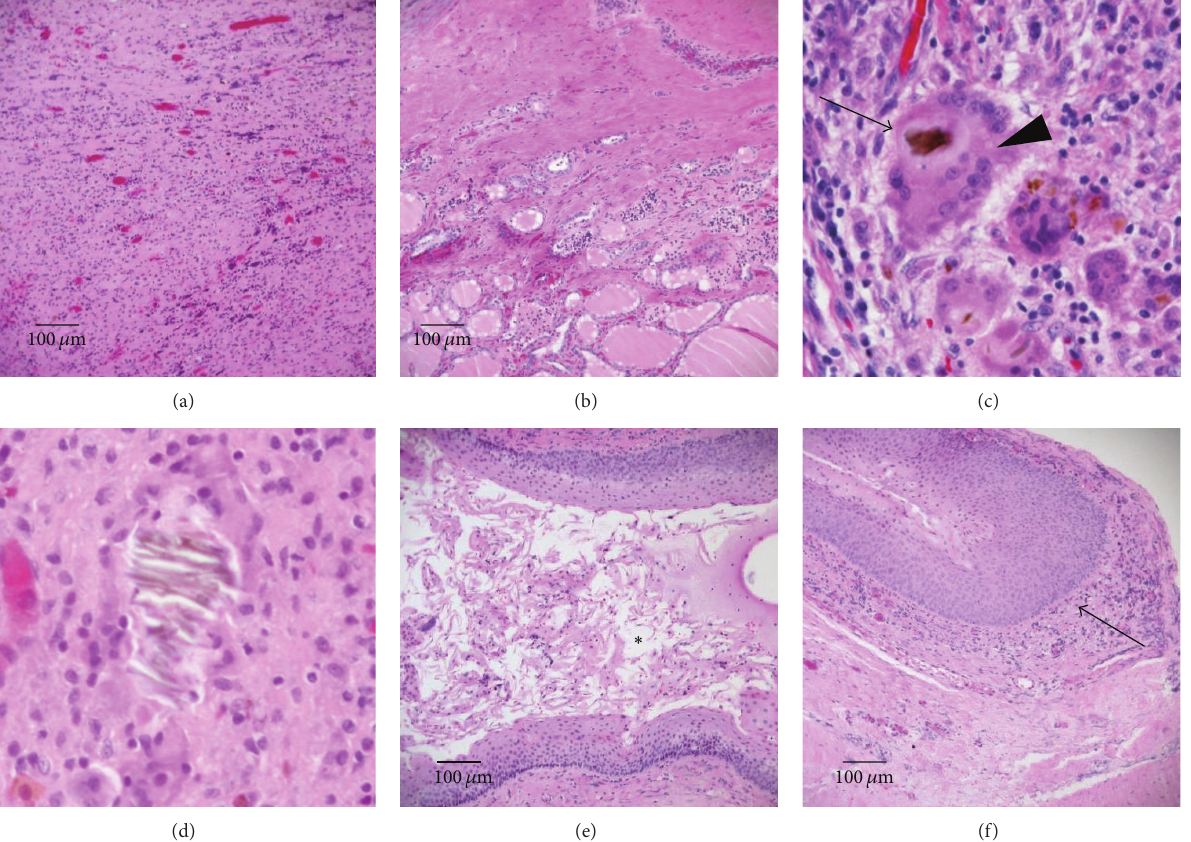
Figure 3: Pathological findings by hematoxylin and eosin staining of the brownish tract ((a)–(d)) and the crystal violet-stained tract ((e), (f)) and a view of the ends of the tracts ((b), (f)). (a) Epithelium of the lumen was completely replaced by granulation tissue and inflammatory cells. (b) The end of the brownish tract has invaded the thyroid beyond the capsule. (c) The brownish tract contained a foreign substance (arrow) that was surrounded by multinucleated giant cell (arrowhead). (d) Another foreign substance was seen in the granulation tissue of the brownish tract. These substances are observed everywhere, which proved the previous communication with the pharyngeal lumen. (e) An internal lumen (asterisk) covered by epithelium has obviously formed. (f) The terminus is a blind end (arrow) that does not enter the thyroid across the